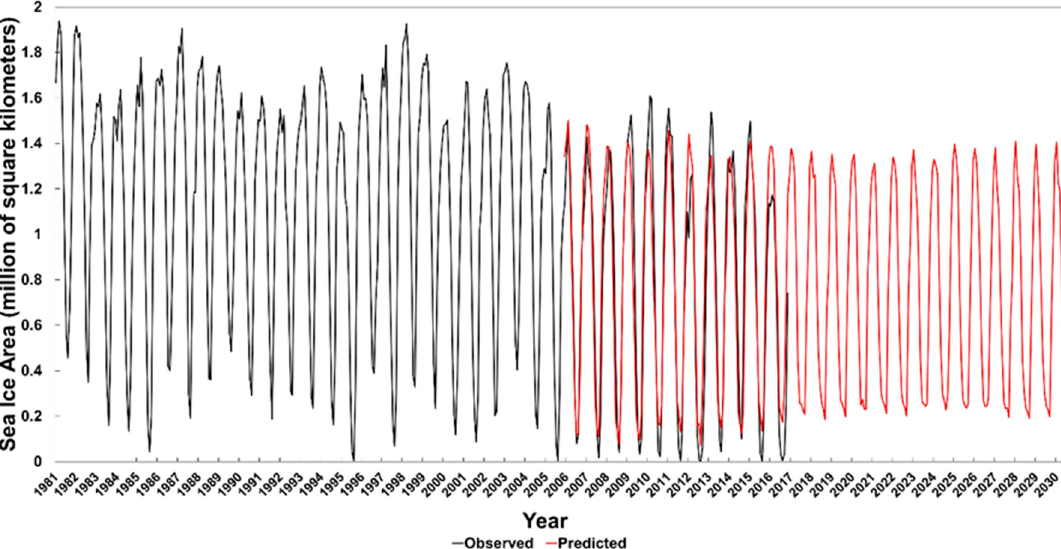
Figure 11. Monthly averages of sea ice area from satellite observations (black dotted line) and the